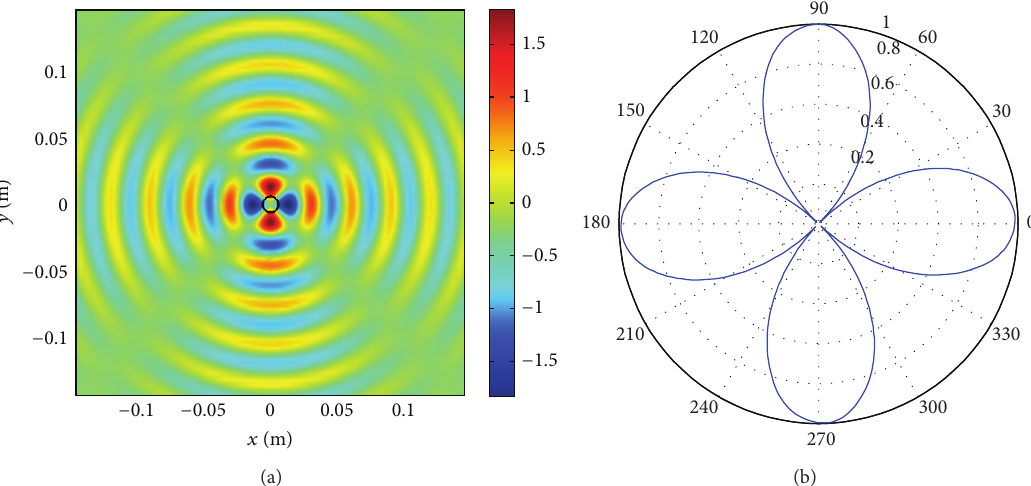
Figure 4: The simulation result of a quadripole radiation (color online). (a) The electric field distribution in the 𝑥 - 𝑦 plane. (b) The far-field radiation pattern with a petal